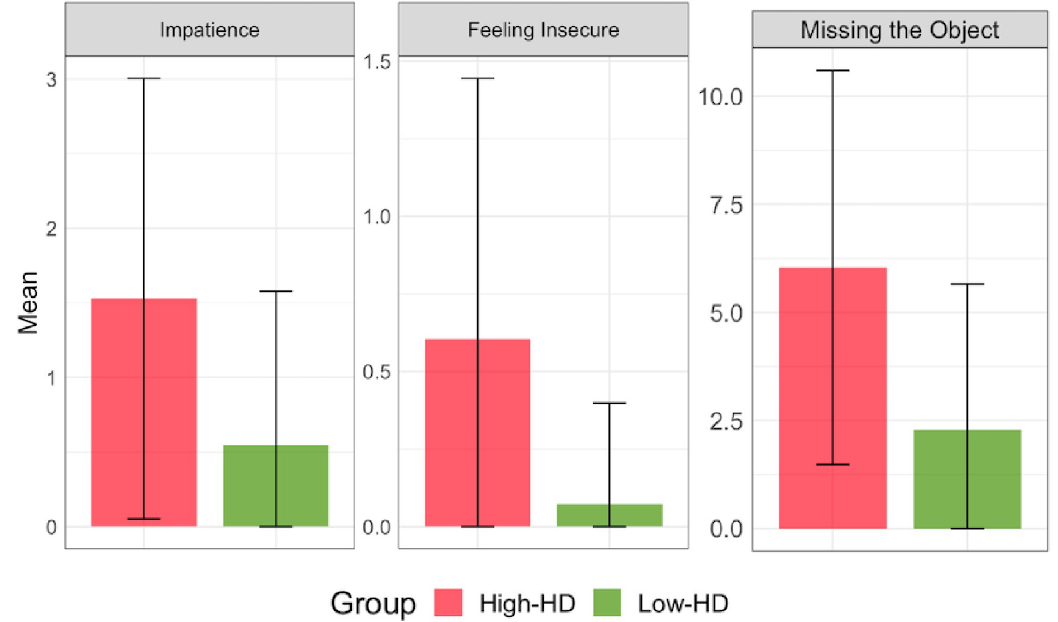
Fig 5. Differences between groups in the types of thoughts reported during the